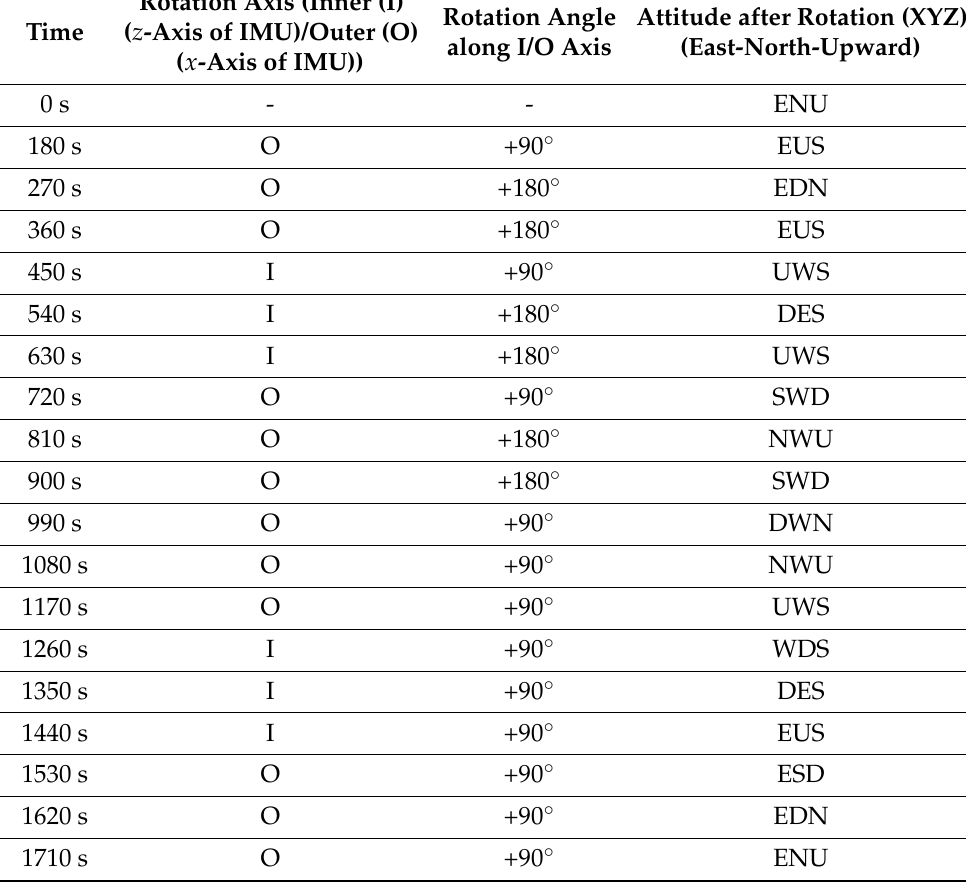
Table 2. Rotation path of self-calibration process.